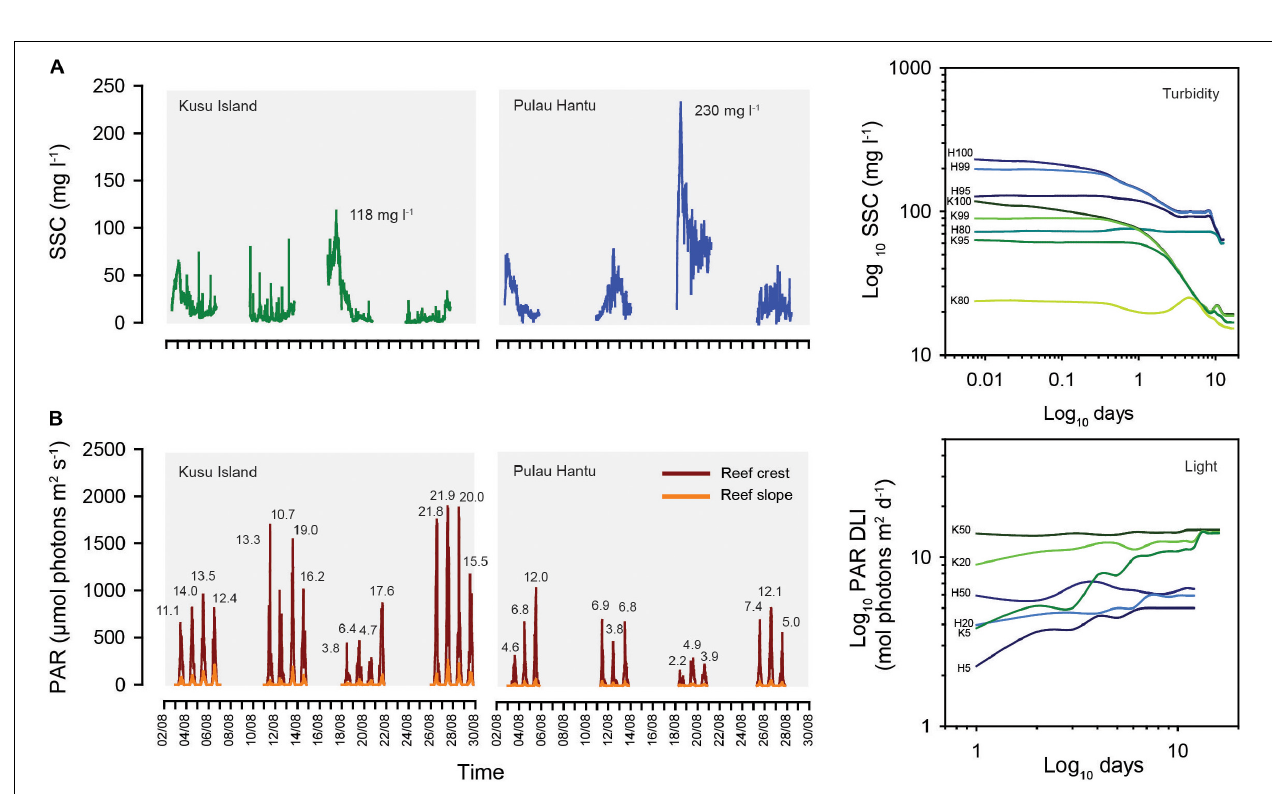
FIGURE 3 | Time-series data over the 30-day deployment for (A) suspended sediment concentration (SSC; mg l − 1 ) and (B) instantaneous PAR measurements ( µ mol photons m − 2 s − 1 ) at Kusu Island (K/green) and Pulau Hantu (H/blue). Daily light integrals (DLI: mol photons m − 2 day − 1 ) for reef crest sites are shown above each light profile. Panels on the right show percentile plots of the running means percentile analysis for suspended sediment concentration and light at both reefs. The 100th (maximum), 99th and 95th and 80th percentiles (for turbidity) and 50th, 20th, 5th (for light) of the running means are displayed.